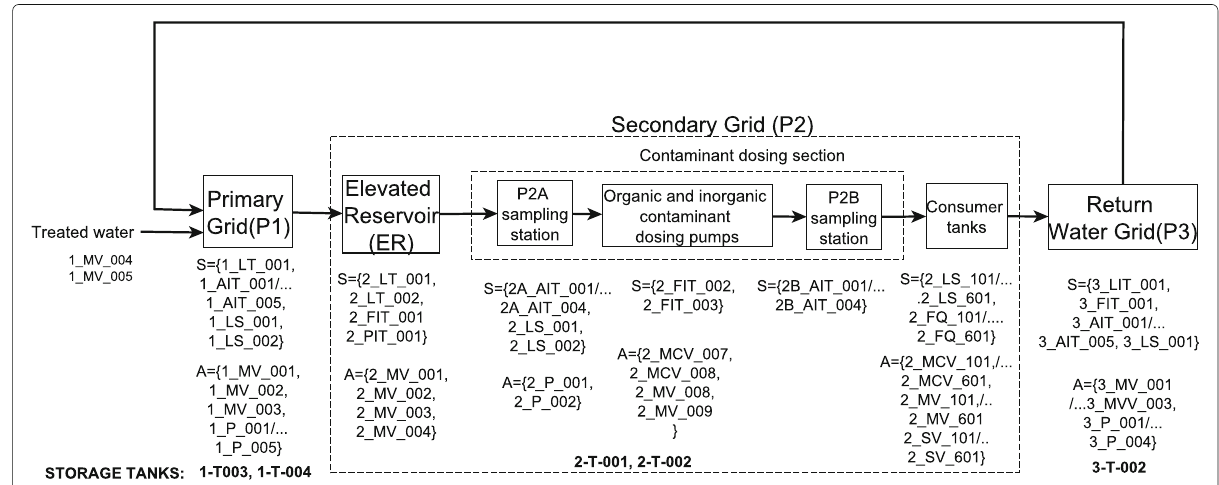
Fig. 2 Overview of the three stages of WADI. Solid arrows indicate the flow of water and the sequence of processes; component names are of the form stage - type - index , e.g. 1-LT-001 is a Level Indication Transmitter in stage